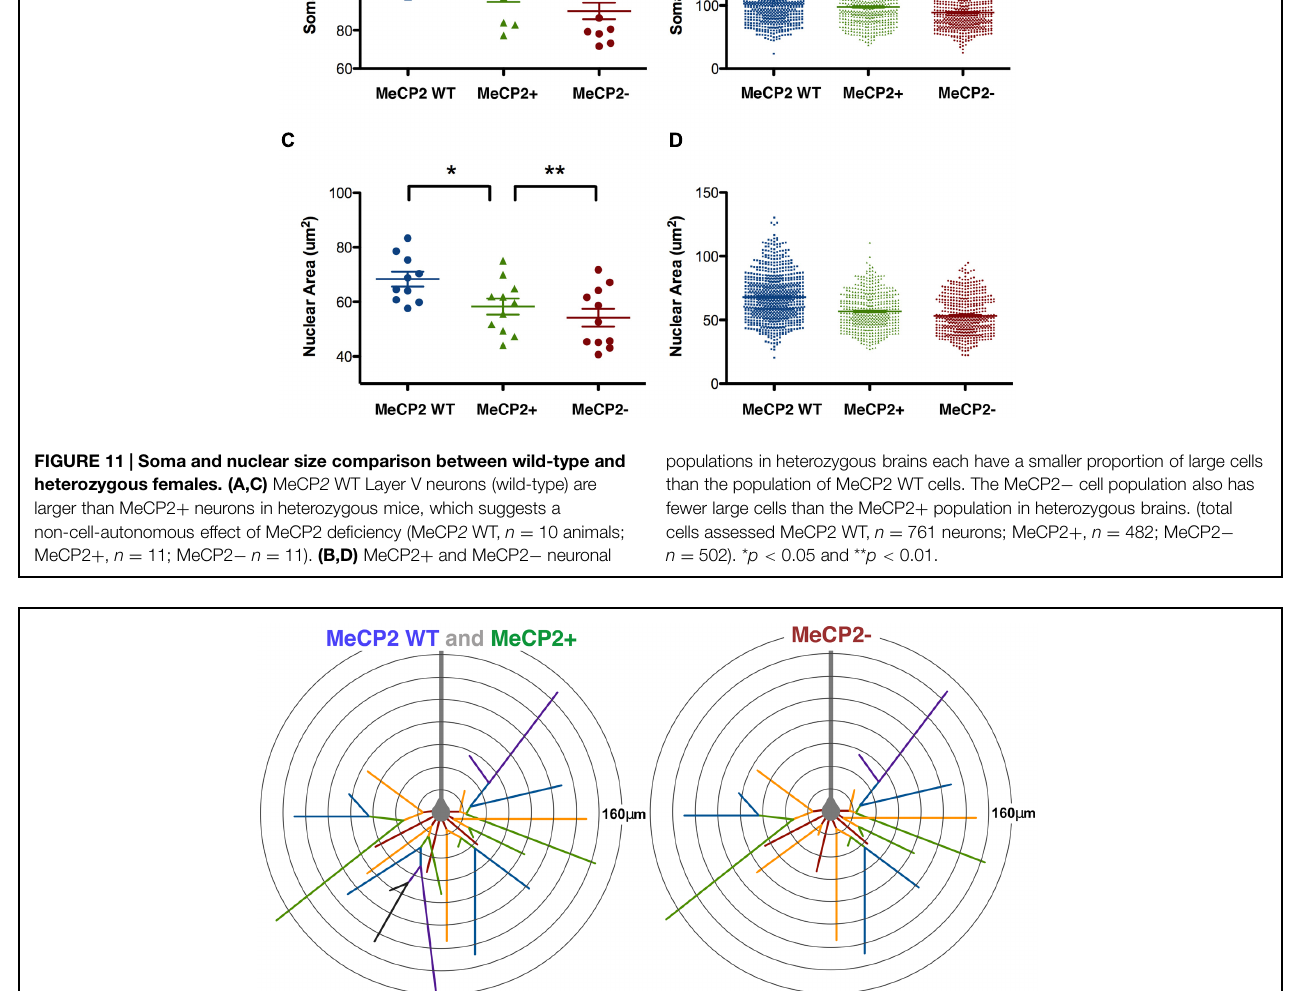
FIGURE 12 | Diagram of average MeCP2 WT, MeCP2 + , and MeCP2 − layer V pyramidal neurons. The average MeCP2 WT and MeCP2 + neurons are equivalent across all morphological parameters investigated except soma and nuclear size. The average MeCP2 − neuron (right) has approximately 15% less total dendritic length compared to either of the other genotypes. The average MeCP2 − neuron has three fewer branch points, leading to a reduced